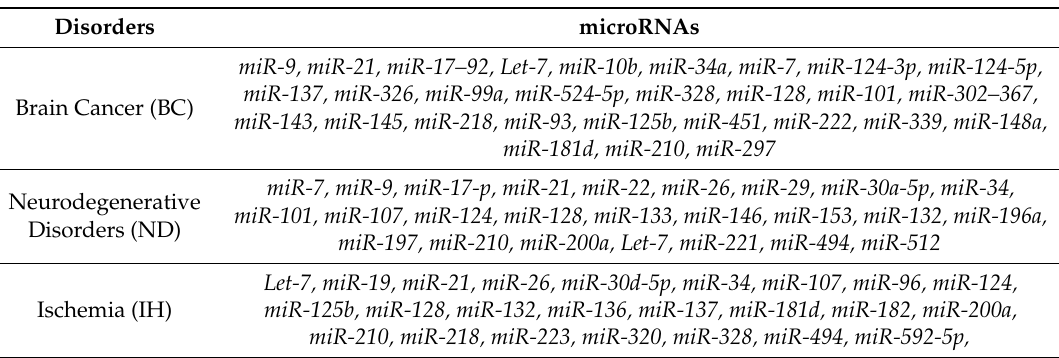
Table 2. List of microRNAs deregulated in brain disorders.